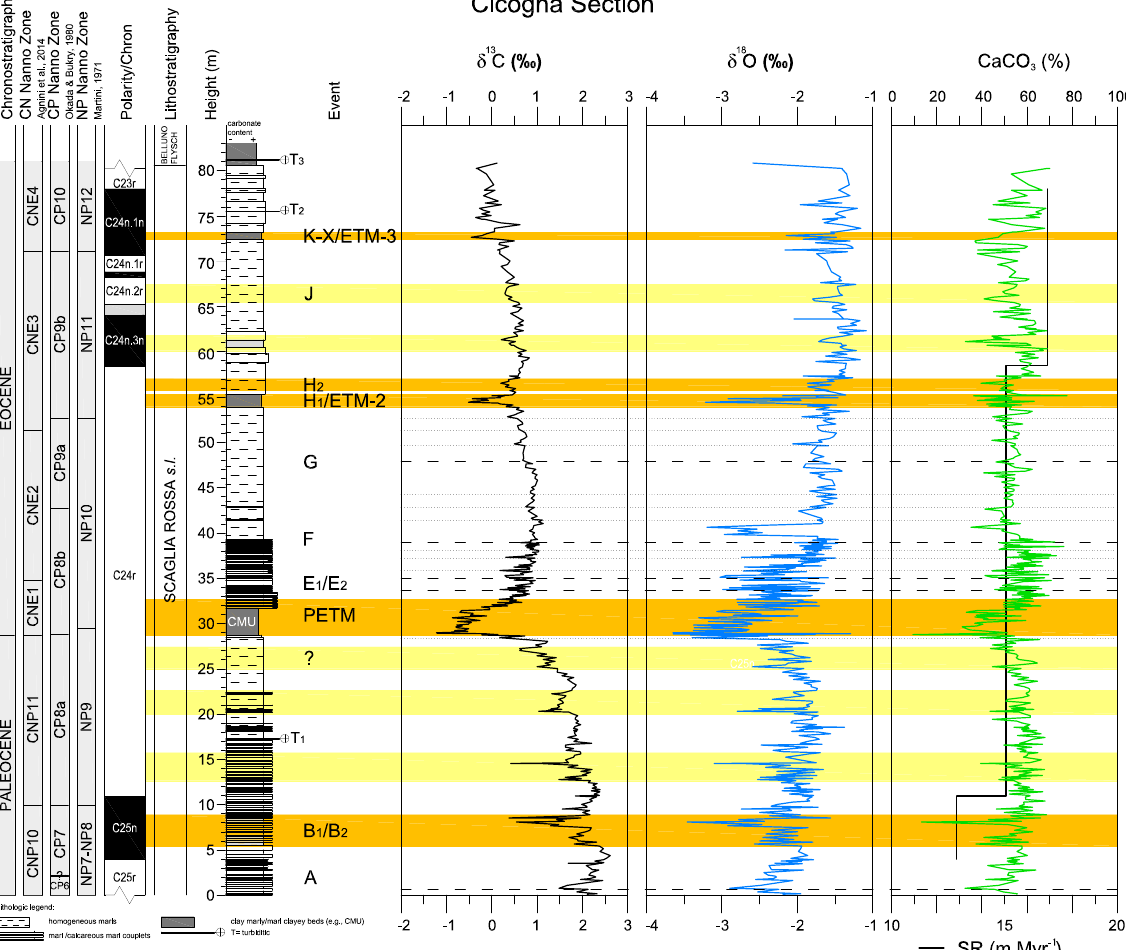
Figure 4. The Cicogna section with records of bulk carbonate δ 13 C and δ 18 O data, and CaCO 3 content. Calcareous nannofossil biostratig- raphy (CP and NP biozones) and magnetostratigraphy are after Dallanave et al. (2009); CN biozones are also reported. Orange and yellow bands mark major δ 13 C excursions. Dashed lines indicate minor CIEs that have been labeled elsewhere (e.g., E1/E2, F and G; Cramer et al., 2003), whereas dotted lines indicate minor changes in δ 13 C that appear to occur also at ODP Site 1262 (see also Fig.